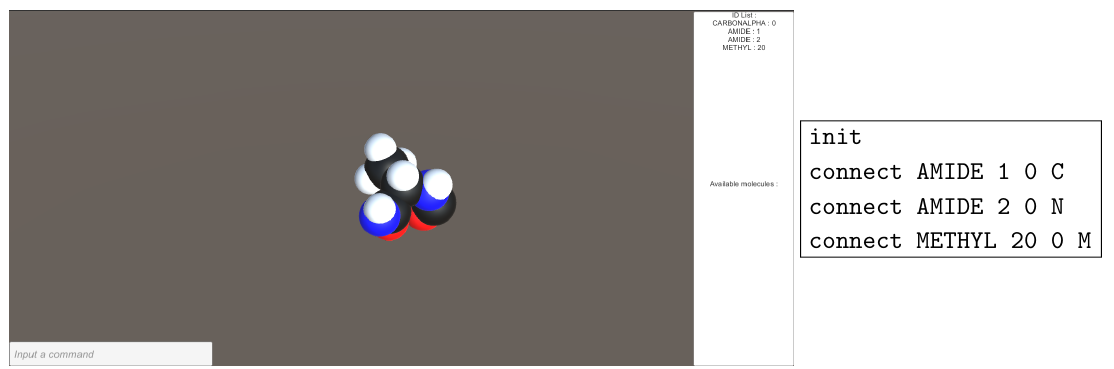
Figure 19. CLI generated molecules Figure 17. Command Line Input (CLI) generated molecules.